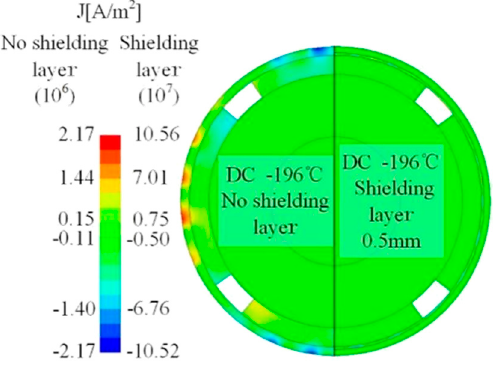
Figure 13. The rotor eddy current-density distribution cloud diagram at low temperature.